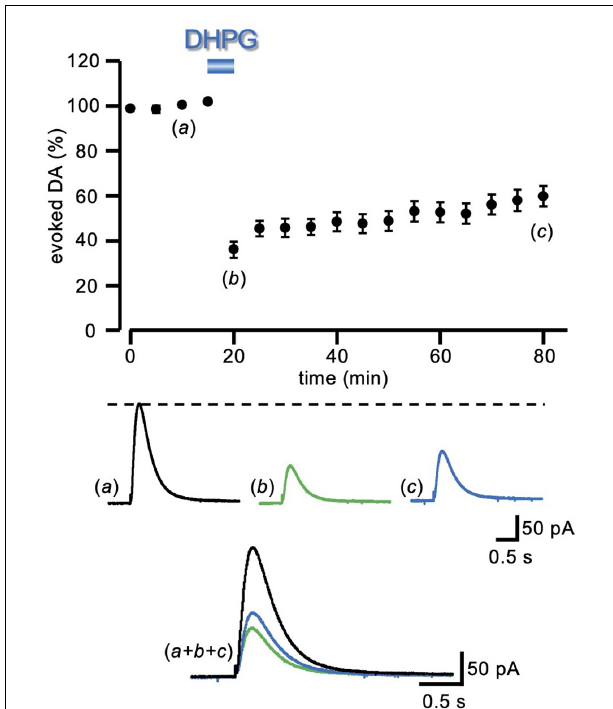
FIGURE 1 | LTD of evoked DA induced by DHPG. Running plots of the relative (%) mean amplitude ( ± s.e.m.) of evoked DA release, obtained with amperometric recordings in striatal slices, with a local electrical stimulation delivered at 5 min intervals ( n = 23 slices from nine animals). Bath perfusion with DHPG (50 µ M) for 5 min caused a pronounced depression of the DA signal, which remained depressed after 60 min of drug washout. At the bottom, representative traces of the DA signal are shown at the time indicated by the letters in the plot. LTD, long-term depression; DA, dopamine; DHPG, (S)-3,